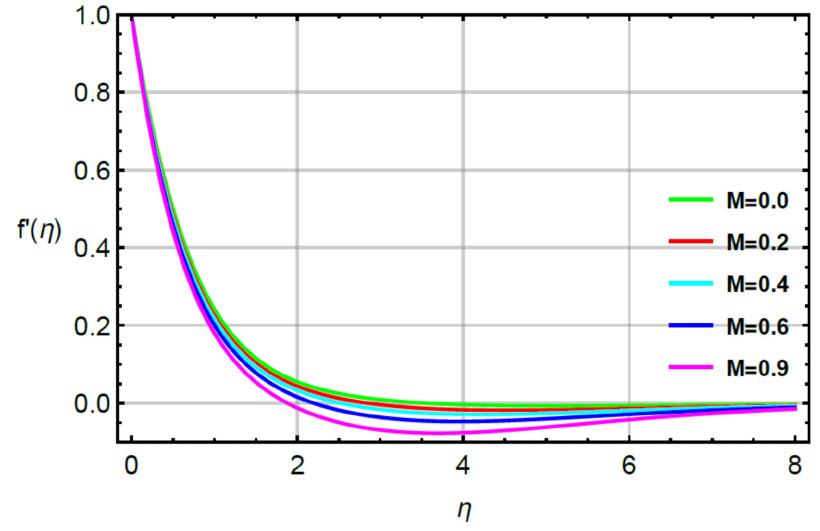
Figure 2. Behavior of f (cid:48) ( η ) for M when R = 0.1, Sc = 0.6, Pr = 1.1, α 1 = 0.2 = α 2 , γ 1 = 0.3 = γ 2 , δ = 0.8.